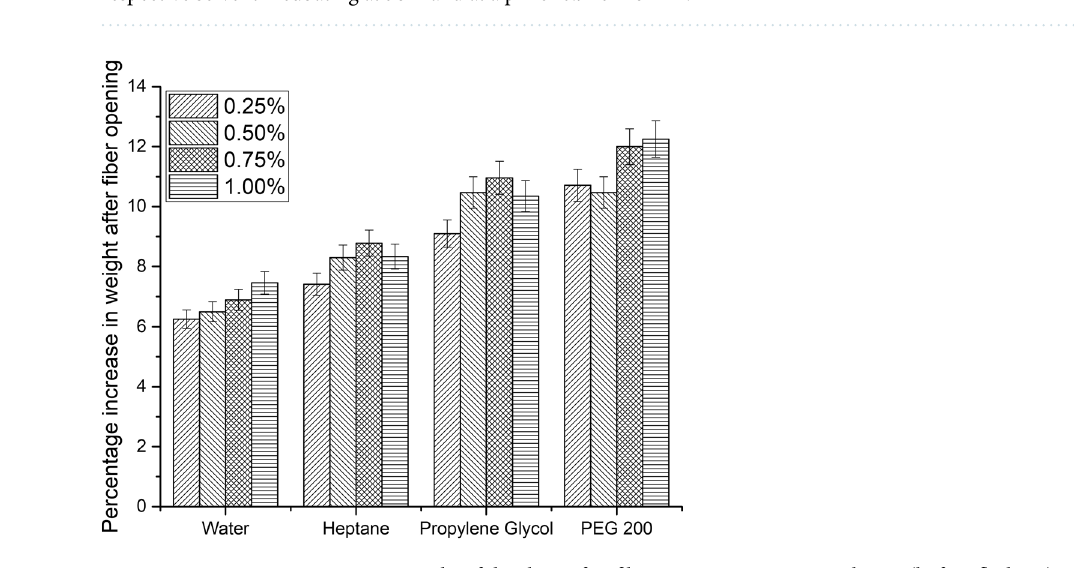
Figure 4. Percentage increase in weight of the skins after fiber opening in various solvents (before